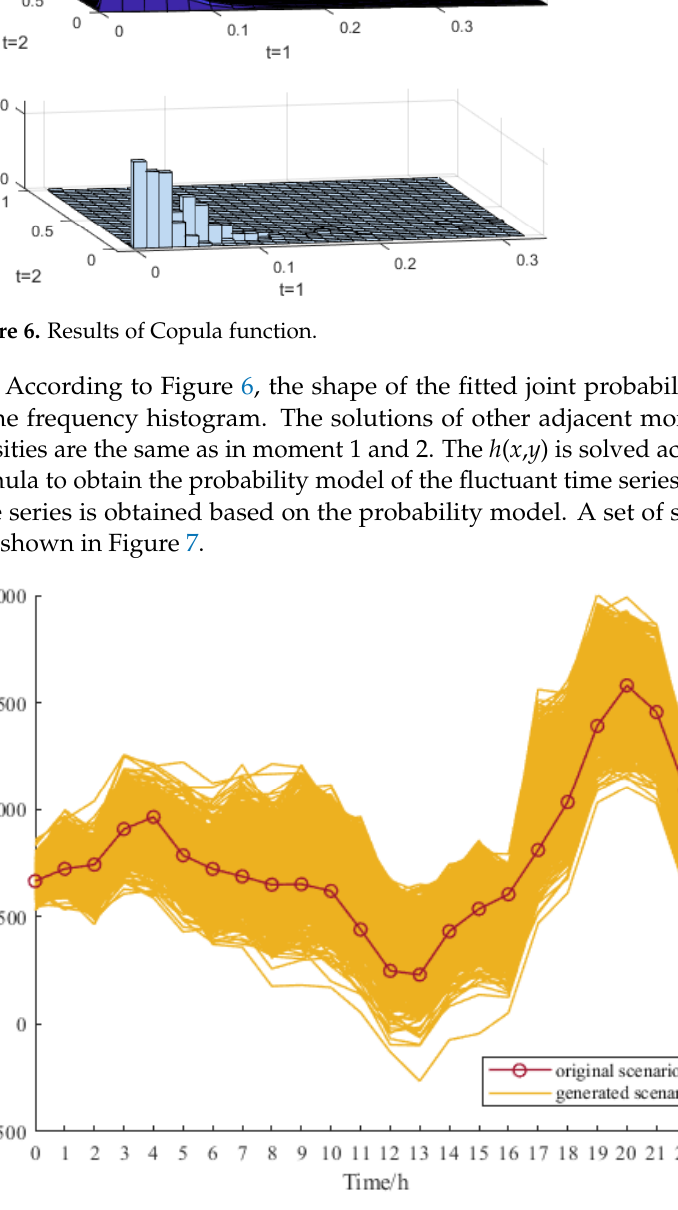
Figure 5. Results of marginal distribution.